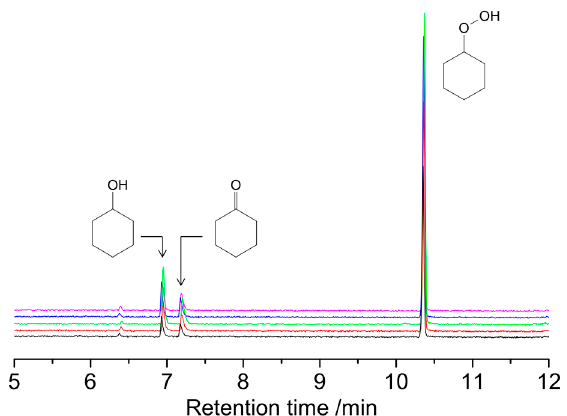
Figure 9. Fragments of the chromatograms of the reaction samples (2 h time) recorded before the addition of PPh 3 (Phenomenex ZB-5 column). Small peaks at 6.4 min were assigned to cyclohexene oxide formed as a product of partial decomposition of CyOOH during the GC analysis.